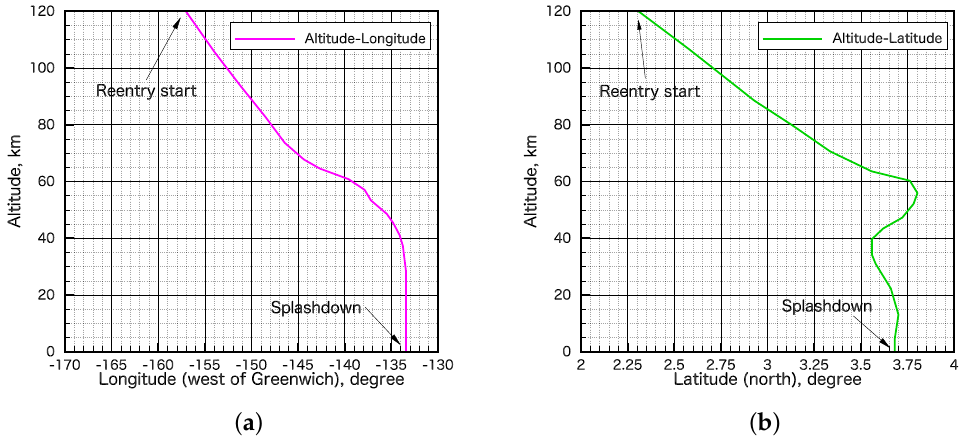
Figure 2. Reentry trajectory of the ESA atmospheric reentry demonstrator (ARD). ( a ) Altitude-longitude profile; ( b ) altitude-latitude profile.